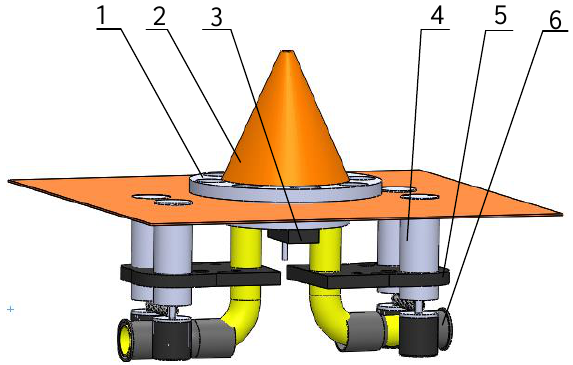
Figure 2. The launcher structure. 1. Cross turntable; 2. Diversion device; 3. Steering gear; 4. Motor; 5. Fixed plate; 6. Launch tube.